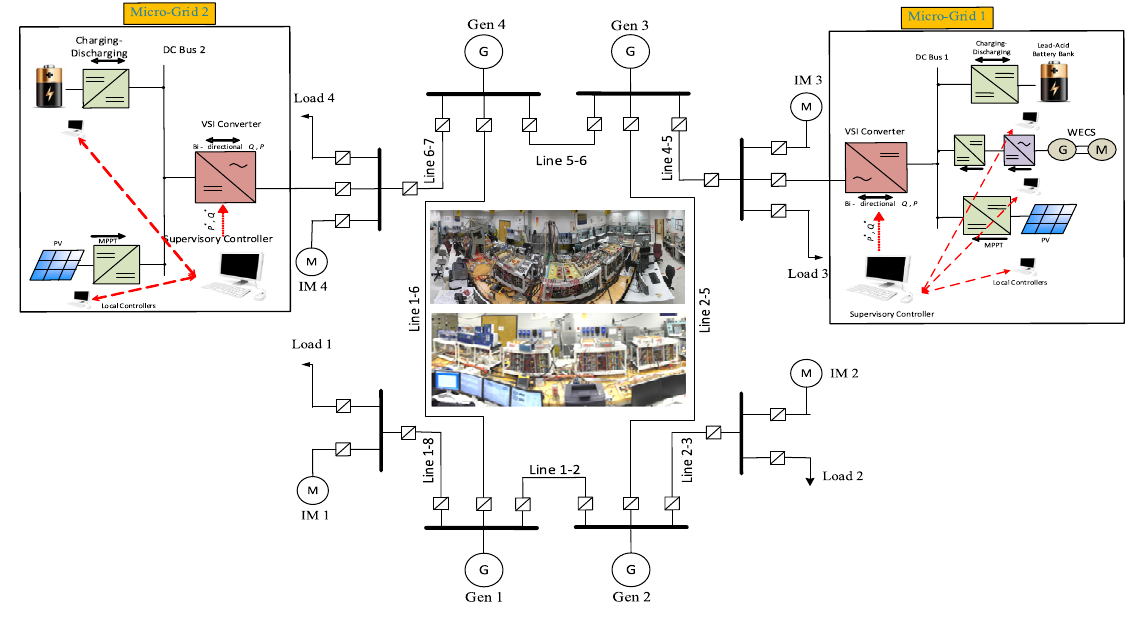
Figure 1. Schematic diagram for the smart grid testbed.